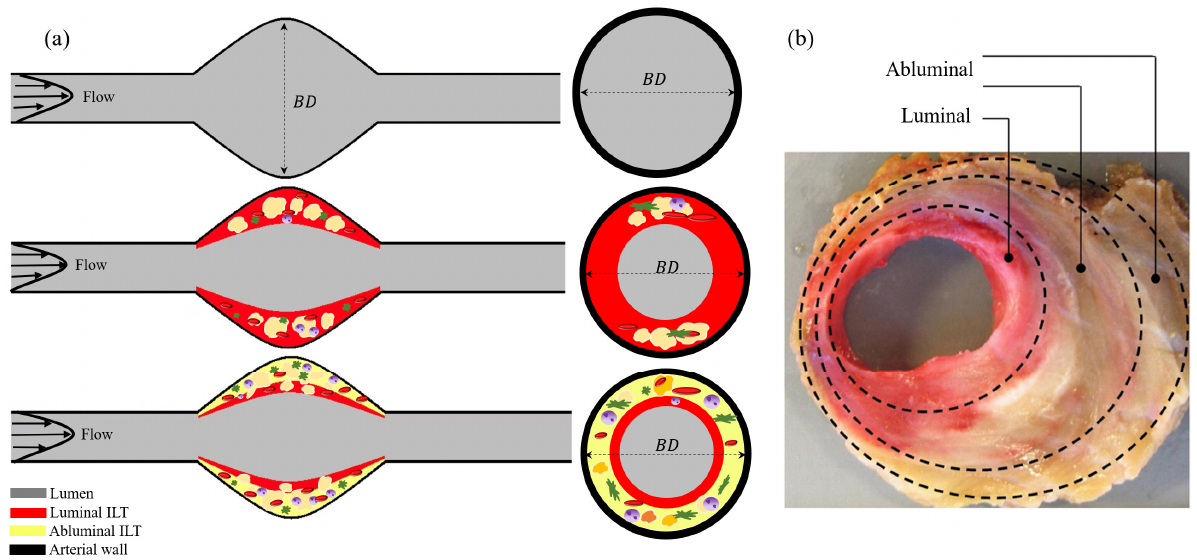
Figure 1. ( a ) A schematic of three-dimensional, axially symmetric AAA geometries used in this study is shown, including a model which lacks an ILT, a model containing a homogeneous ILT layer, and a model with a multi-layered ILT demonstrating its heterogeneity. In the two-layer ILT models, the abluminal layer and luminal layer thickness are two-thirds and one-third, respectively. BD represents the bulge diameter of the aneurysm. ( b ) Cross-section of the bulk ILT tissue harvested from elective human AAA repair, where luminal and abluminal layers are indicated; adapted with permission from [18], Elsevier, 2022.